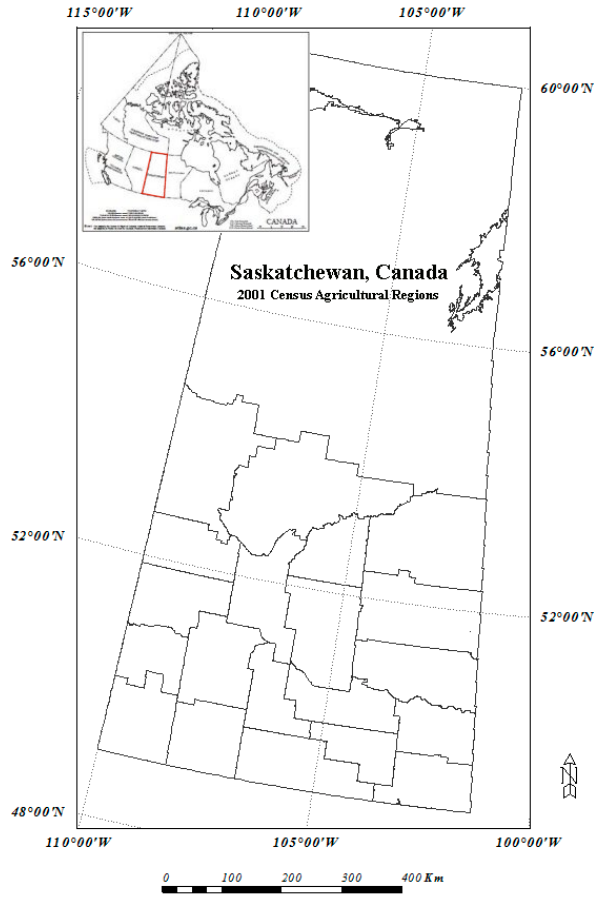
Figure 1. The study region—southern Saskatchewan, Canada. The polygons are Census Agricultural Regions (CARs).